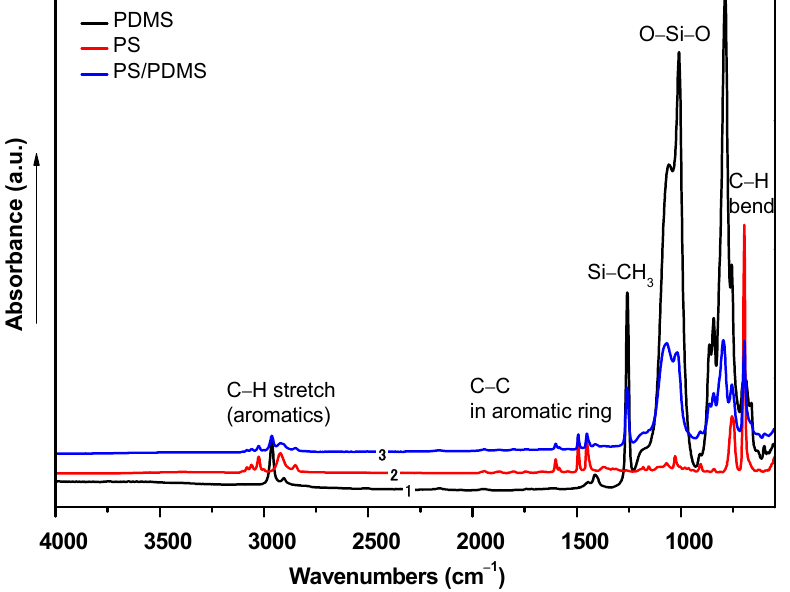
Figure 4. FTIR spectra of PS, PDMS and PDMS/PS electrospun fiber mats.